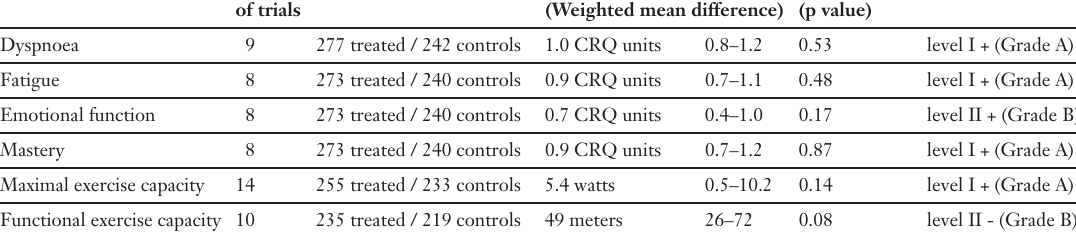
Primary results of the